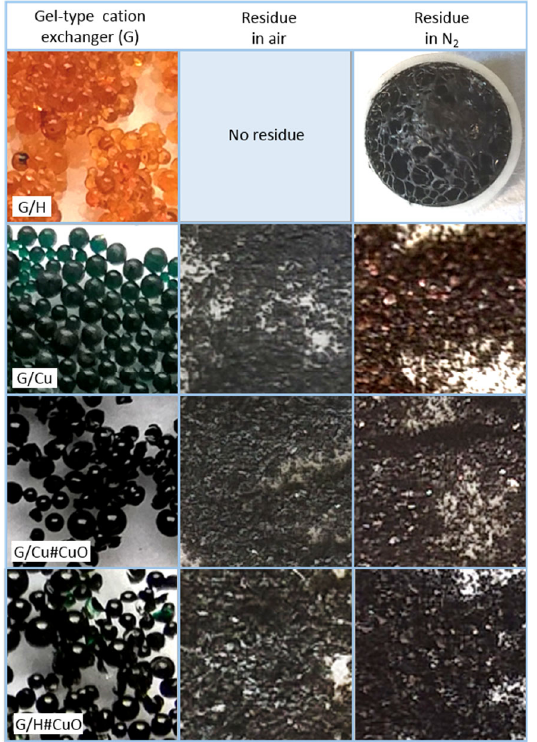
Figure 2. Photographs of examined materials based on gel ‐ type carboxylic cation exchanger (left column), solid residues after their thermal analysis in air (middle column) and in N 2 (right column).